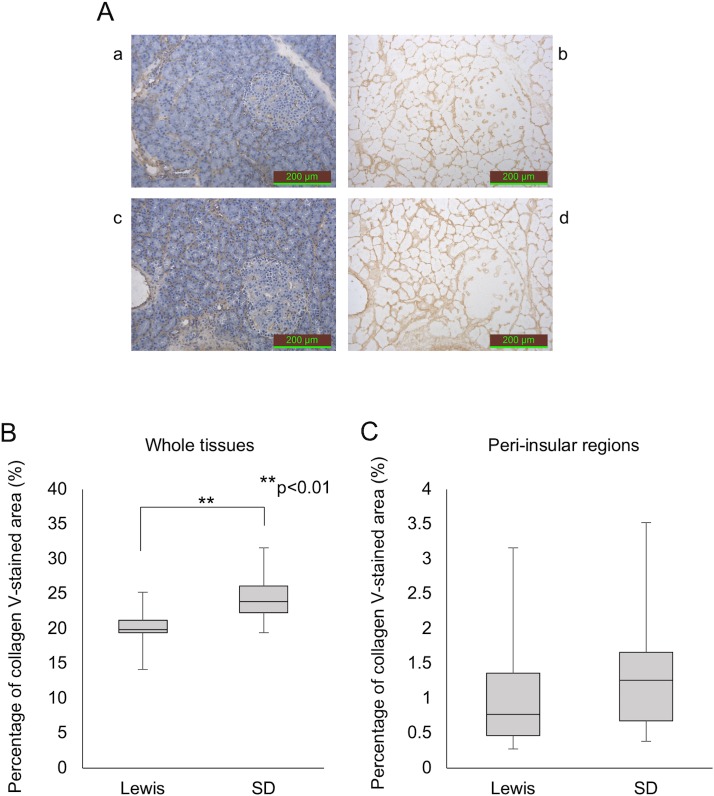
Anti-collagen V staining of the pancreatic tissues in each rat strain.(A) Anti-collagen V staining (a and b: Lewis rat; c and d: SD rat). The stained area was calculated using pictures without hematoxylin staining (b, d). (B) The percentage of the overall anti-collagen V-stained area. (C) The percentage of the anti-collagen V-stained area in the peri-insular region only.